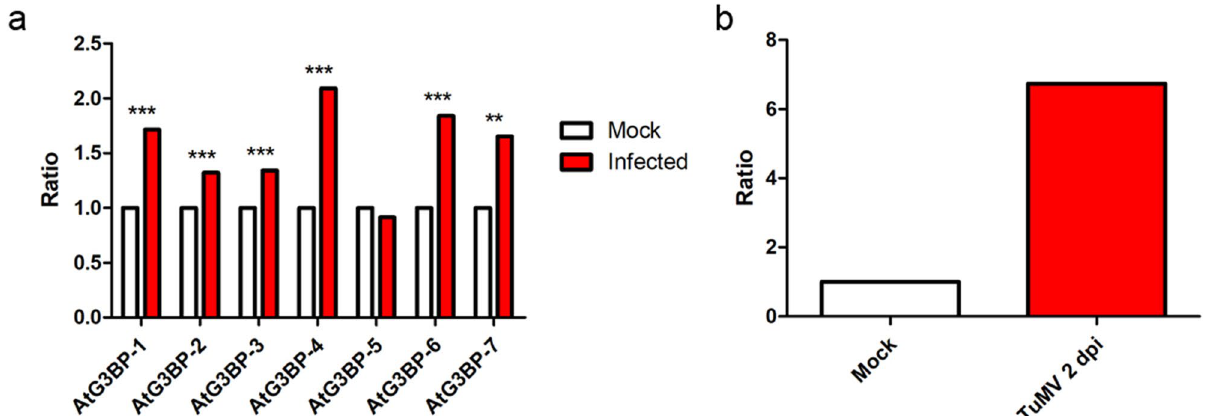
Figure 6. Expression level analyses. ( a ) Transcript abundance in TuMV-infected leaf tissue was measured and compared to non-infected tissue to determine the regulation of the expression level of the different AtG3BPs, AtActin-2 served as the internal control. The asterisks indicate significance measured by two-tailed t-test (** = p < 0.01; *** = p < 0.005) ( b ) qRT-PCR analysis for verification of RNAseq data. AtG3BP-4 expression level in TuMV infection sites 2 dpi was measured and compared to mock-inoculated tissue.